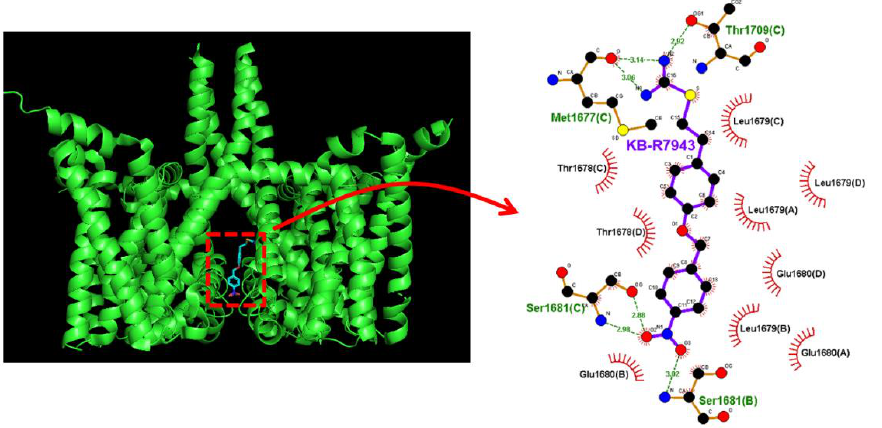
Figure 8. Molecular docking of the hNa V 1.7 channel and the KB-R7943 molecule. The chemical structure of KB-R7943 was acquired from PubChem (compound CID: 9823846), whereas the protein structure of hNa V 1.7 was from RCB PDB (ID: 5EK0). We docked the KB-R7943 molecule to hNa V 1.7 with the help of PyRx software (http://pyrx.sourceforge.io/) (accessed on 16 September 2022), and the diagram of the interaction between the hNa V 1.7 channel and the KB-R7943 molecule was then generated from LigPlot + (http://www.ebi.ac.uk/thornton-srv/software/LIGPLOT/) (accessed on 16 September 2022). Note that the red arcs on which red small bars are faced and radiated toward the ligand (i.e., KB-R7943 molecule) represent the hydrophobic interactions, while green dotted lines residing in amino acid residue (i.e., Ser1681(B), Ser1681(C), Thr1709(C) and Met1877(C)) show the formation of hydrogen bonds.